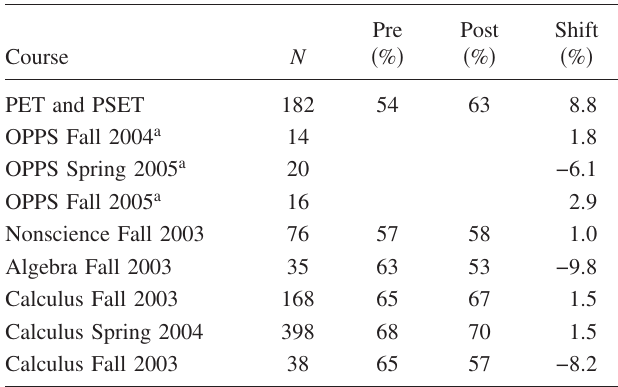
TABLE IV. Comparison of overall CLASS scores for different courses.